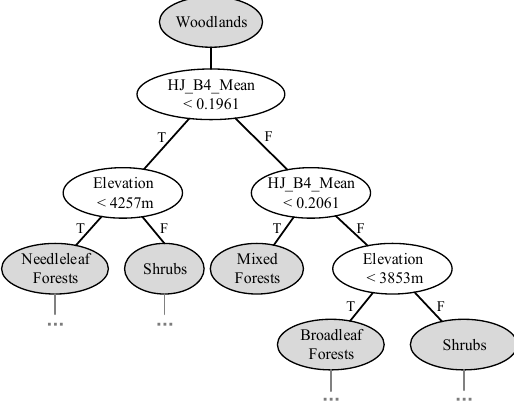
Figure 8. The decision tree for woodlands divisions.